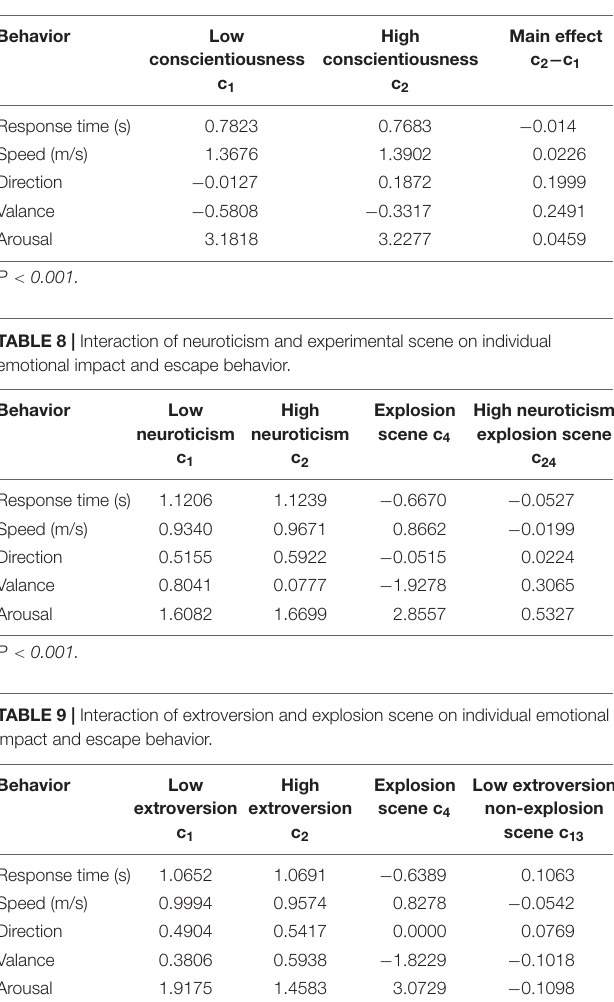
TABLE 7 | The main effect of conscientiousness on escape behavior.